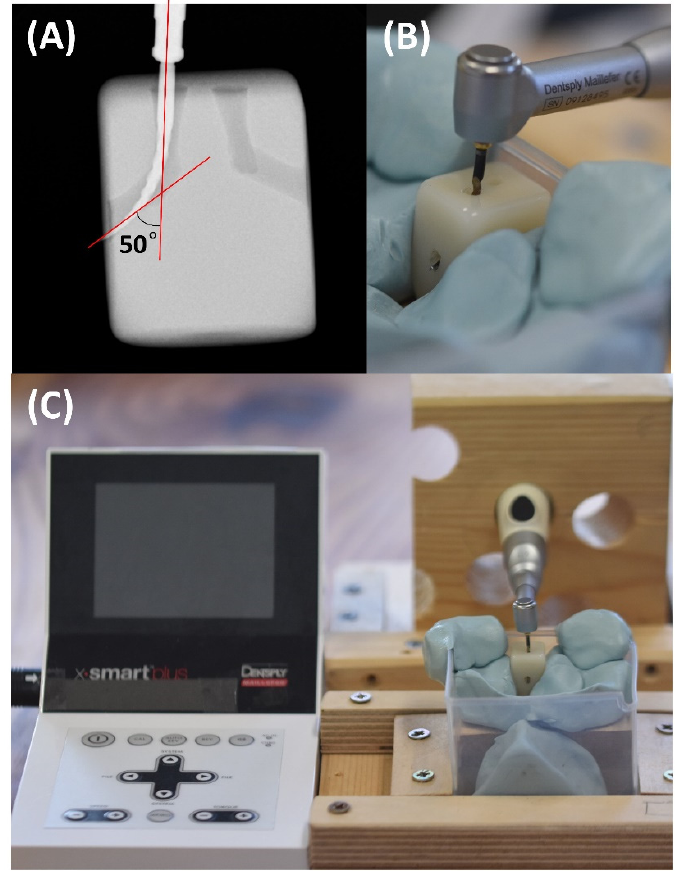
Figure 1. Cyclic fatigue resistance test device. ( A ) radiography of artificial root canal; ( B ) ceramic block used for artificial root canal; ( C ) endodontic motor connected to cyclic fatigue testing device.